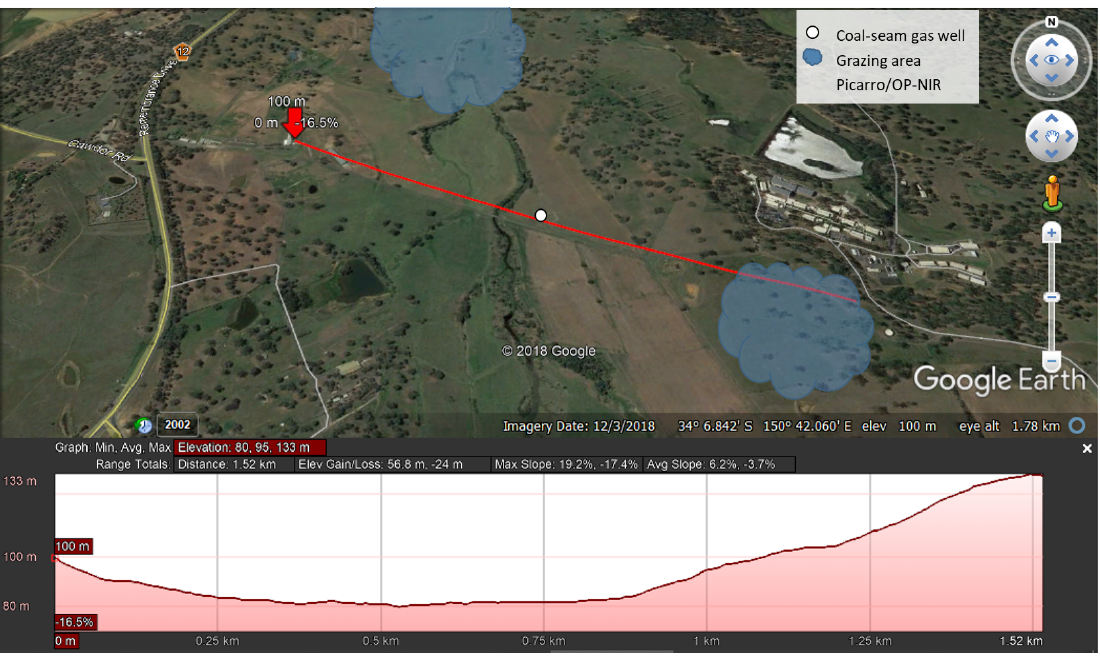
Figure 8. Map of the 1.55km path at EMAI and corresponding elevation profile. The OP-NIR and stationary Picarro were located at the left end of the path and the retroreflector array at the right end. The mean elevation across the 1.55km observation path is 118m above sea level, an average of 23m above surface elevation. Map © Google Earth.